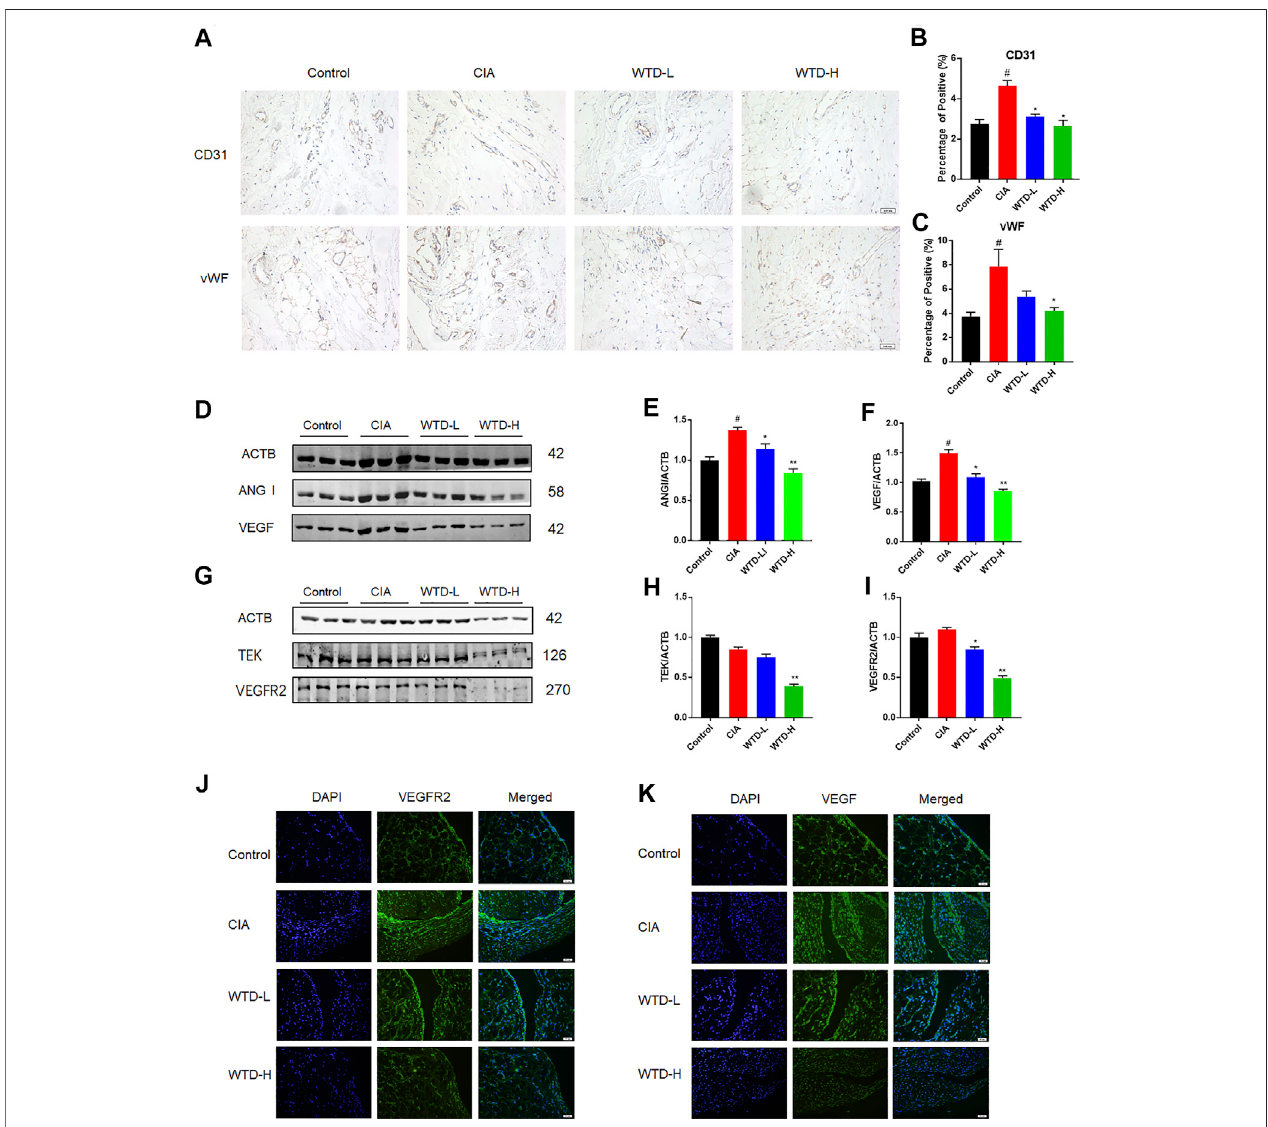
FIGURE 3 | WTD inhibited angiogenesis in the synovial tissues of CIA rats. (A) Representative immunohistochemical staining for CD31 and vWF in synovial sections. Scale bar: 100 μ m. (B – C) Quantitative analysis of immunohistochemical staining for CD31 and vWF in synovial tissue. (D) Representative western blots showing VEGF and ANGI after WTD treatment. (E – F) Quantitative analysis of VEGF and ANGI. (G) Representative western blots showing VEGFR2 and TEK after WTD treatment. (H – M) Quantitative analysis of the VEGFR2 and TEK western blots after WTD treatment. (N – O) Representative immuno fl uorescence staining of VEGF and VEGFR2 in synovial sections. Scale bar: 50 μ m. The results were expressed as mean ± SE. N (cid:2) 6. # p < 0.05, ## p < 0.01 versus the control group; * p < 0.05, ** p < 0.01 versus the CIA group. CIA, The Collagen-induced arthritis group; WTD-L, the low dose Wutou decoction group (3.75 g/kg/day); WTD-H, the high dose Wutou decoction group (7.5